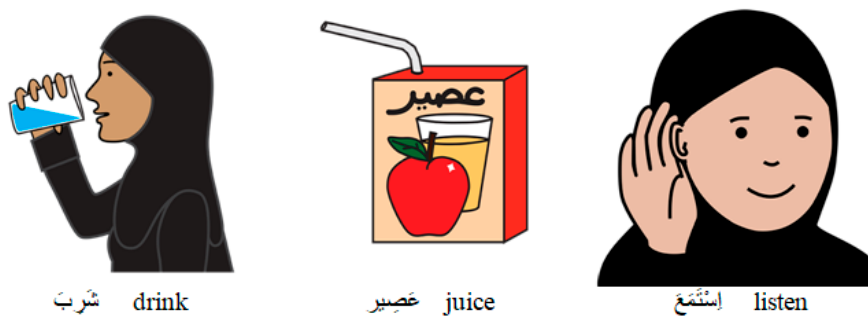
Figure 1. Tawasol symbols and their English/Arabic matching word [21].